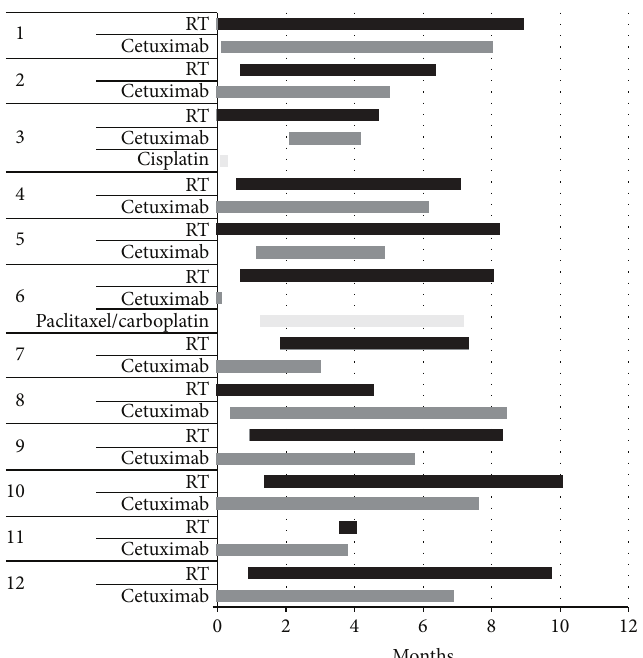
Figure 1: Relationship of cetuximab and radiotherapy. The duration of treatment and relationship in time for radiotherapy, cetuximab, and other systemic therapies is presented.